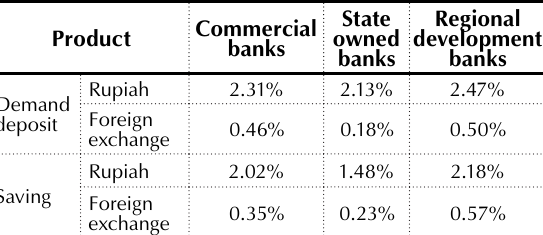
Table 4. Average of interest rate of third party funds